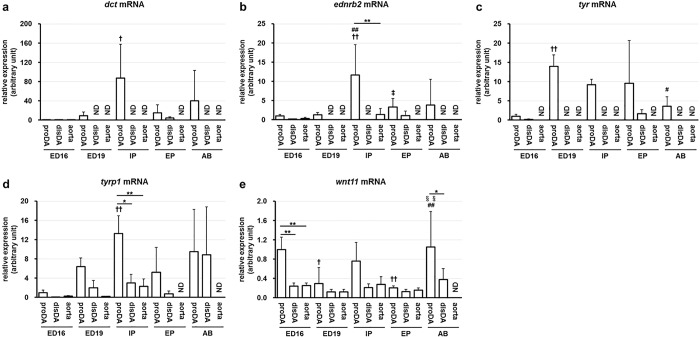
Quantitative PCR analysis for melanogenesis/tyrosine metabolism-related genes.The relative mRNA levels of each gene, dct (a), ednrb2 (b), tyr (c), tyrp1 (d) or wnt11 (e), to gapdh were quantified by RT-PCR. We performed this experiment in quintuplicate and noted results as ND only if we could not detect any signals from two or more samples among the five available samples. * and ** indicate p < 0.05 and p<0.01, † and †† indicate p < 0.05 and p<0.01 compared to the same tissues of the ED16 stage, # and ## indicate p < 0.05 and p<0.01 compared to the same tissues of the ED19 stage, ‡ and ‡‡ indicate p < 0.05 and p<0.01 compared to the same tissues of the IP stage, §§ indicates p<0.01 compared to the same tissues of the EP stage, n = 5. ND: not detected.